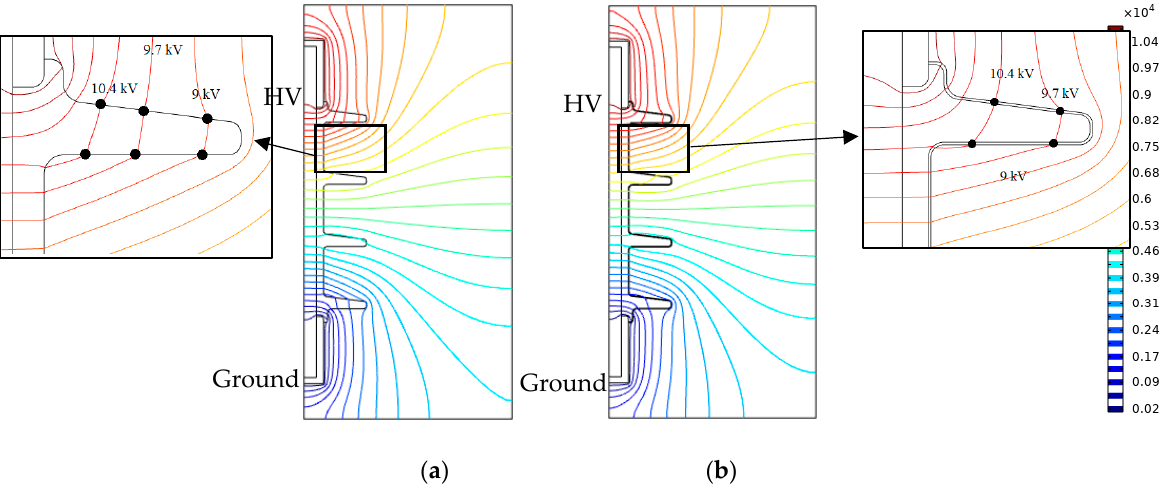
Figure 14. Equipotential around insulator under ( a ) dry clean surface and ( b ) uniformly polluted condition with a single conductivity of 4.2 µS/m.